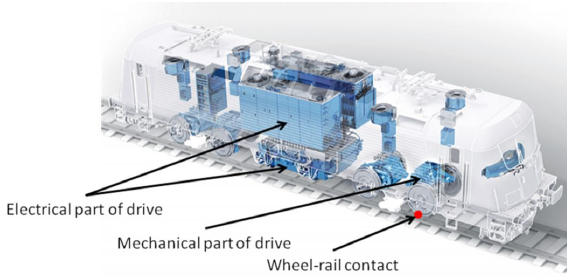
Figure 8. Wheel slip deduction [7].